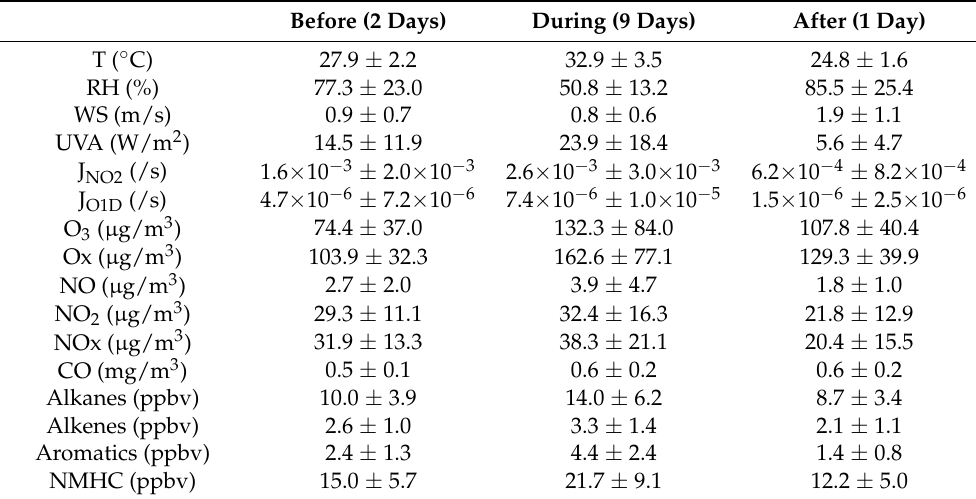
Table 1. Mean value of meteorological, O 3 concentration, and ambient air pollutants before, during, and after polluted period at monitoring